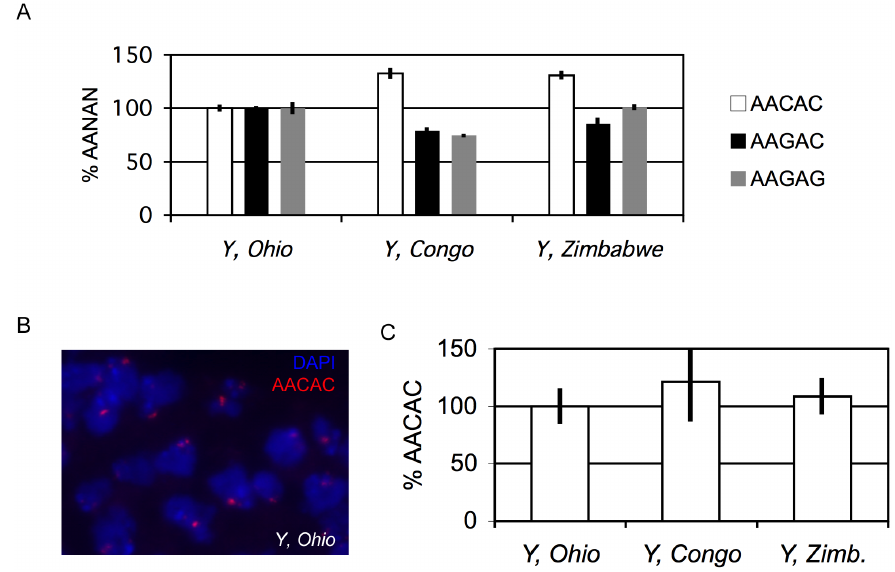
Figure 3. Quantification of Y -linked satellite copy number variation in geographically divergent lines. DNA and tissue samples obtained from males bearing Y chromosomes originally isolated from wild-caught flies. The genetic background of these males was otherwise isogenic. ( A ) Relative quantification of satellite copy number using qPCR. Percentages are relative to Y , Ohio (defined as 100%). Error bars represent standard error of the mean (S.E.M.) of triplicate qPCR reactions. ( B ) Fluorescence in situ hybridization to detect AACAC repeats (red) in squashed neuroblast cells derived from Y , Ohio larvae. DAPI stains DNA blue. ( C ) Quantification of in situ hybridization signals. Percentages calculated relative to Y , Ohio (defined as 100%). Error bars represent standard deviation (S.D.) of nuclei from thirty neuroblasts from each of three separate preparations per genotype (N=90).